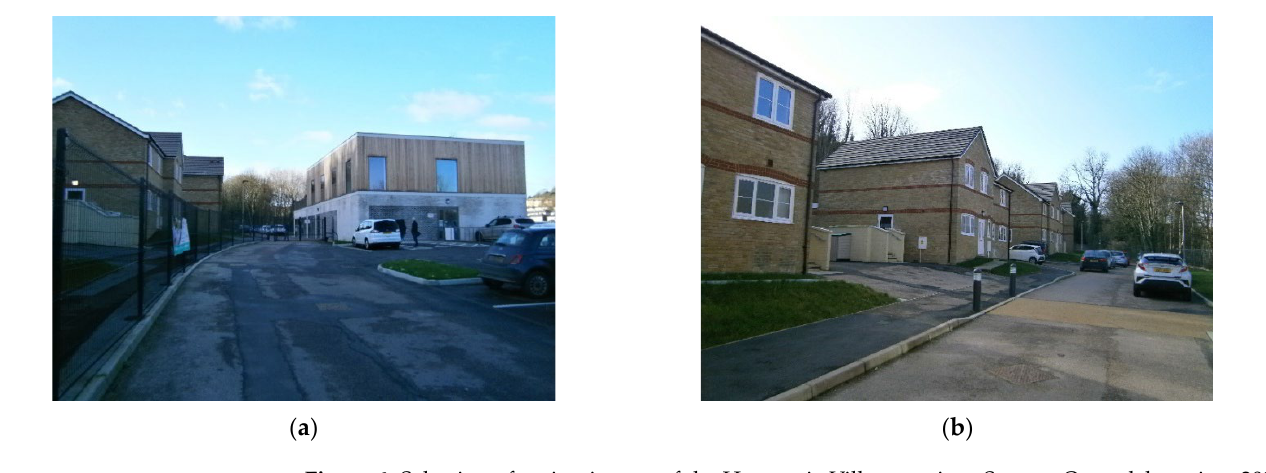
Figure 6. Selection of main pictures of the Harmonia Village project. Source: Own elaboration, 2020. ( a ) The complex is in a cul-de-sac street, just beyond several similar houses and near the Buckland Hospital. The main gate is through a metallic fence for greater security, preventing the persons that live there from going out and controlling the access for visitors. Just after the main gate, the community block welcomes visitors, families, and staff members. There is also a café and several spaces for workshops and community activities. ( b ) The care home is structured as six houses and an extra block for common services. Each one has five rooms, a living room, and a kitchen. The whole complex has been refurbished with a lift in each house and all the requirements to adapt it to accessibility standards.